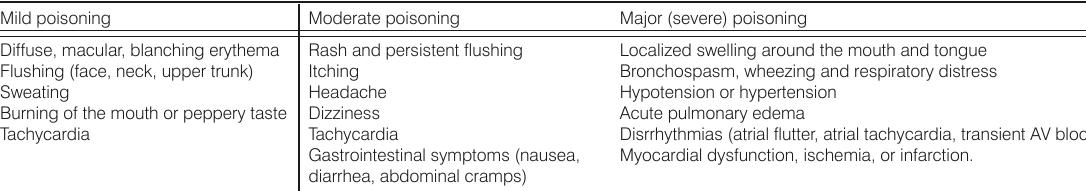
Table 1. Classification and features of scombroid fish poisoning [adapted from 3,